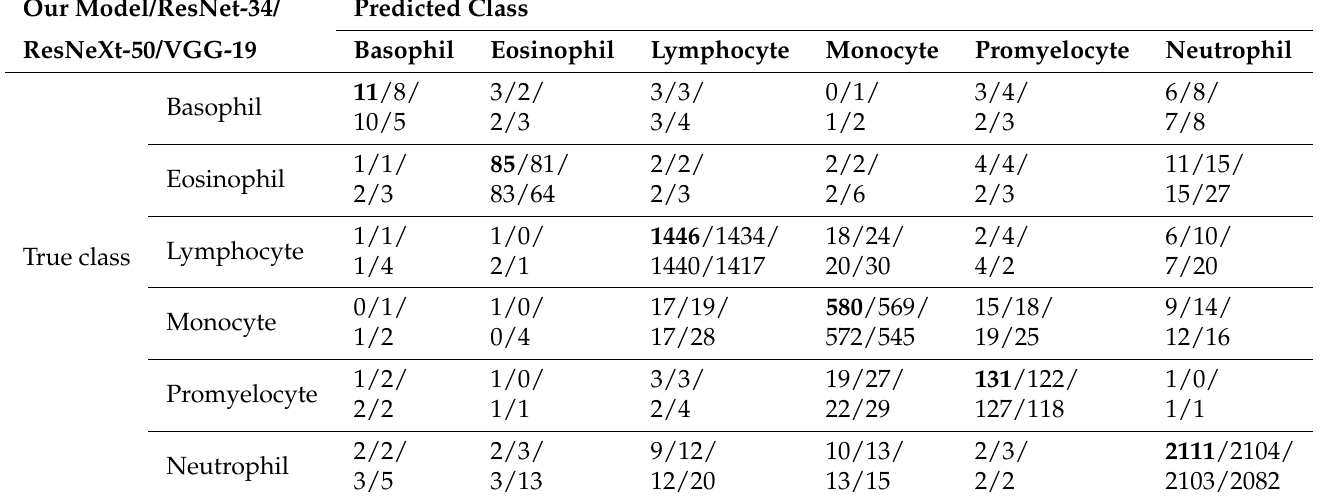
Table 8. The confusion matrix of the classification performance of the four models for the testing data of the combination of two public datasets acquired by rounding off the mean value of five results of 5-fold cross-validation to the nearest whole number (e.g., 0.4 is 0, 0.6 is 1); each number represents the amounts of cells